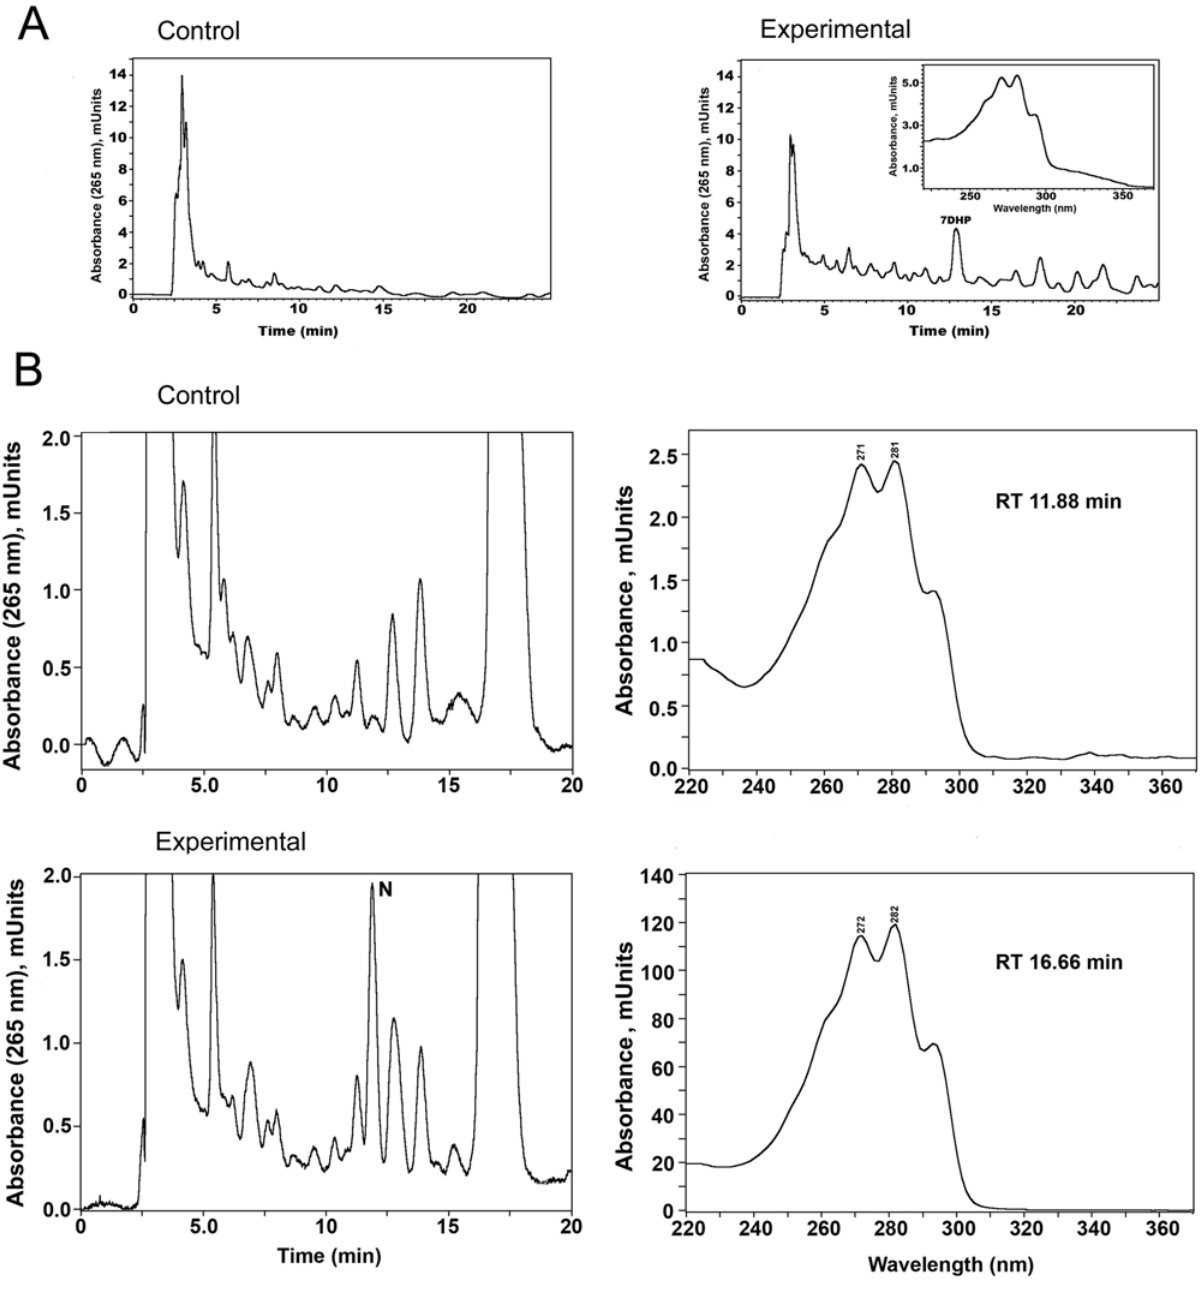
Figure 13. Metabolism of 7DHC and 7DHP by rat skin. A. To study the skin capability to transform 7DHC to 7DHP isolated mitochondria were incubated with 7DHC (0.5 mM) in the presence (experimental) or absence (control) of isocitrate and NADPH. 7DHP: product with the same retention time and UV spectra (inset) as 7DHP standard. B. Incubation of crude skin extract with 7DHP substrate (RT 16.7 min) in the presence of isocitrate and NADPH (experimental) resulted in appearance of a 5,7-diene product ( N ) with RT 11.9 min, which was absent in control reaction mixture (isocitrate and NADPH were not added) (control).